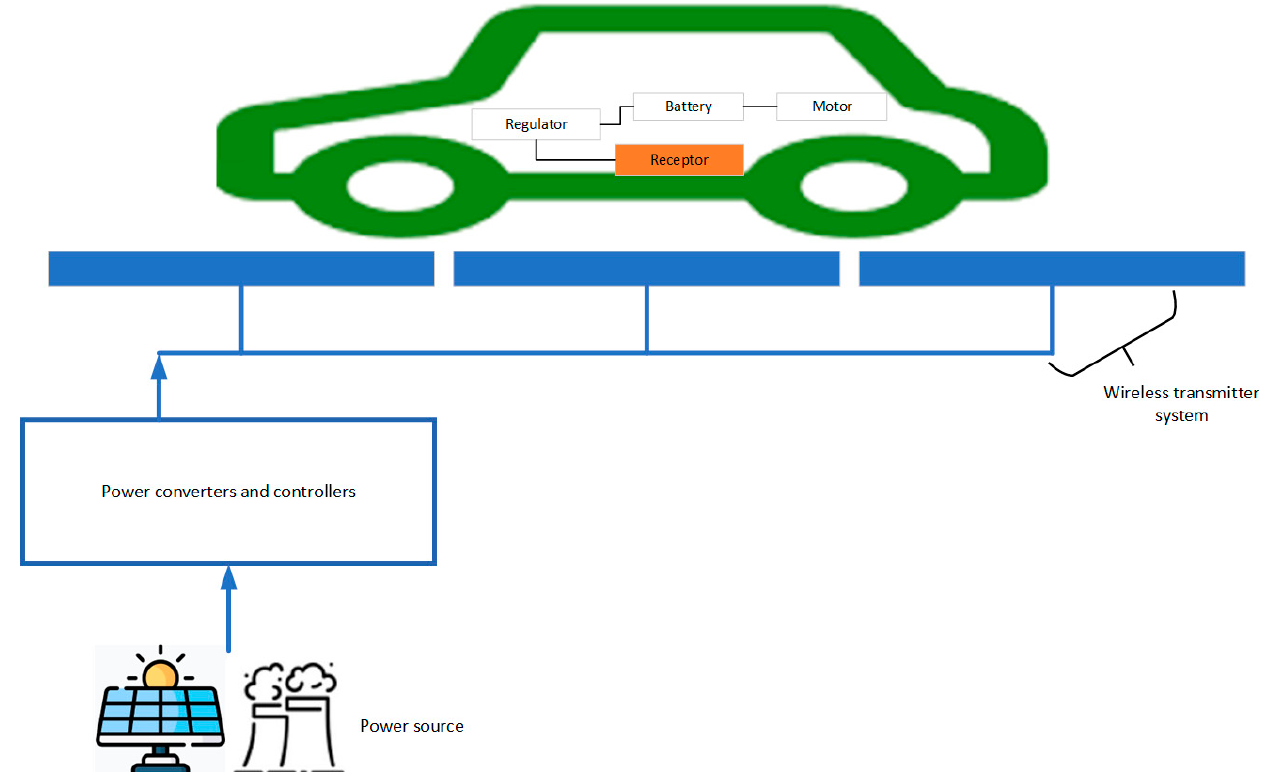
Figure 9. Schematic of dynamic wireless charging of EVs.